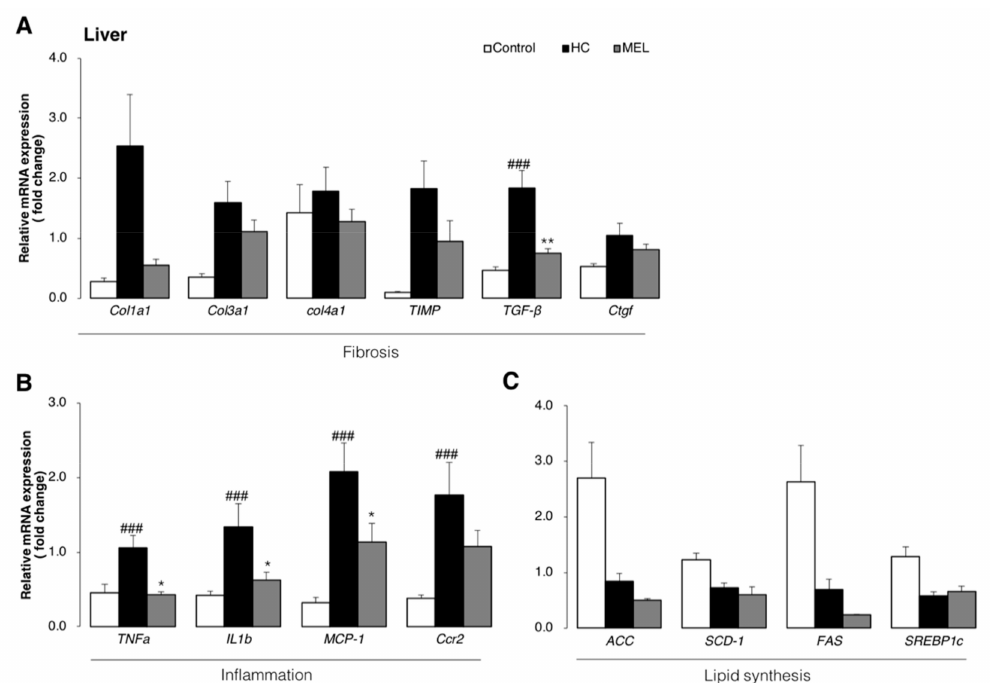
Figure 3. Melon GliSODin ® prevents non-alcoholic hepatic steatosis progression at the level of gene expression. Control diet (Control), high-fat and high-cholesterol diet (HC) and high-fat, high-cholesterol + 1% Melon GliSODin ® diet (MEL). ( A ) Liver mRNA analysis for fibrosis formation. ( B ) Liver mRNA analysis related to inflammation. ( C ) Liver mRNA analysis related to lipid synthesis. Data are presented as mean ± SEM values. n = 7 mice per group. Statistical analysis was performed using one-way ANOVA followed by the Bonferroni’s post hoc test. # / * p < 0.05; ## / ** p < 0.01, ### / *** p < 0.001 versus mice in HC group. ( # Significant di ff erences HC versus Control, *Significant di ff erences HC versus MEL). Furthermore, inflammatory marker genes including tumor necrosis factor-alpha (TNF- α ) and ® interleukin 1-beta (IL-1 β ) were downregulated by Melon GliSODin administration relative to the HC group, almost approaching baseline levels in some cases (Figure